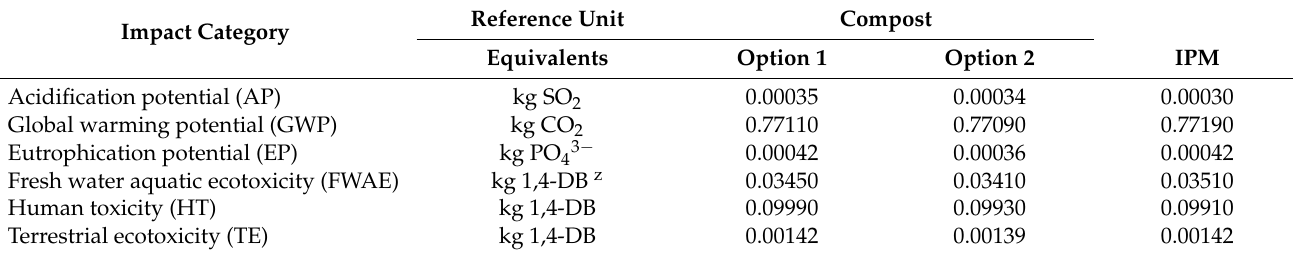
Table 4. Sensitivity analysis for one zonal geranium plant subjected to alternative practices. In relation to garden waste compost addition to the growing medium in option 1, NPK content of compost does not replace fertilizers and in option 2 NPK content replaces part of the mineral fertilizers applied through